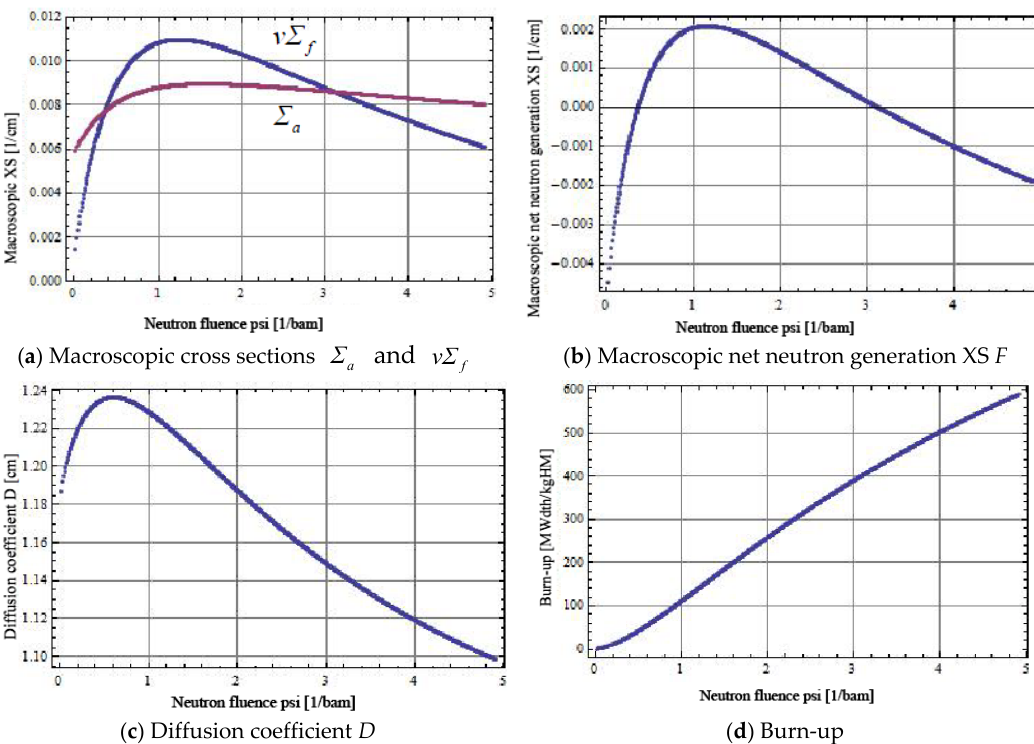
Σ , νΣ , F and D and the burn ‐ up as functions of  a f